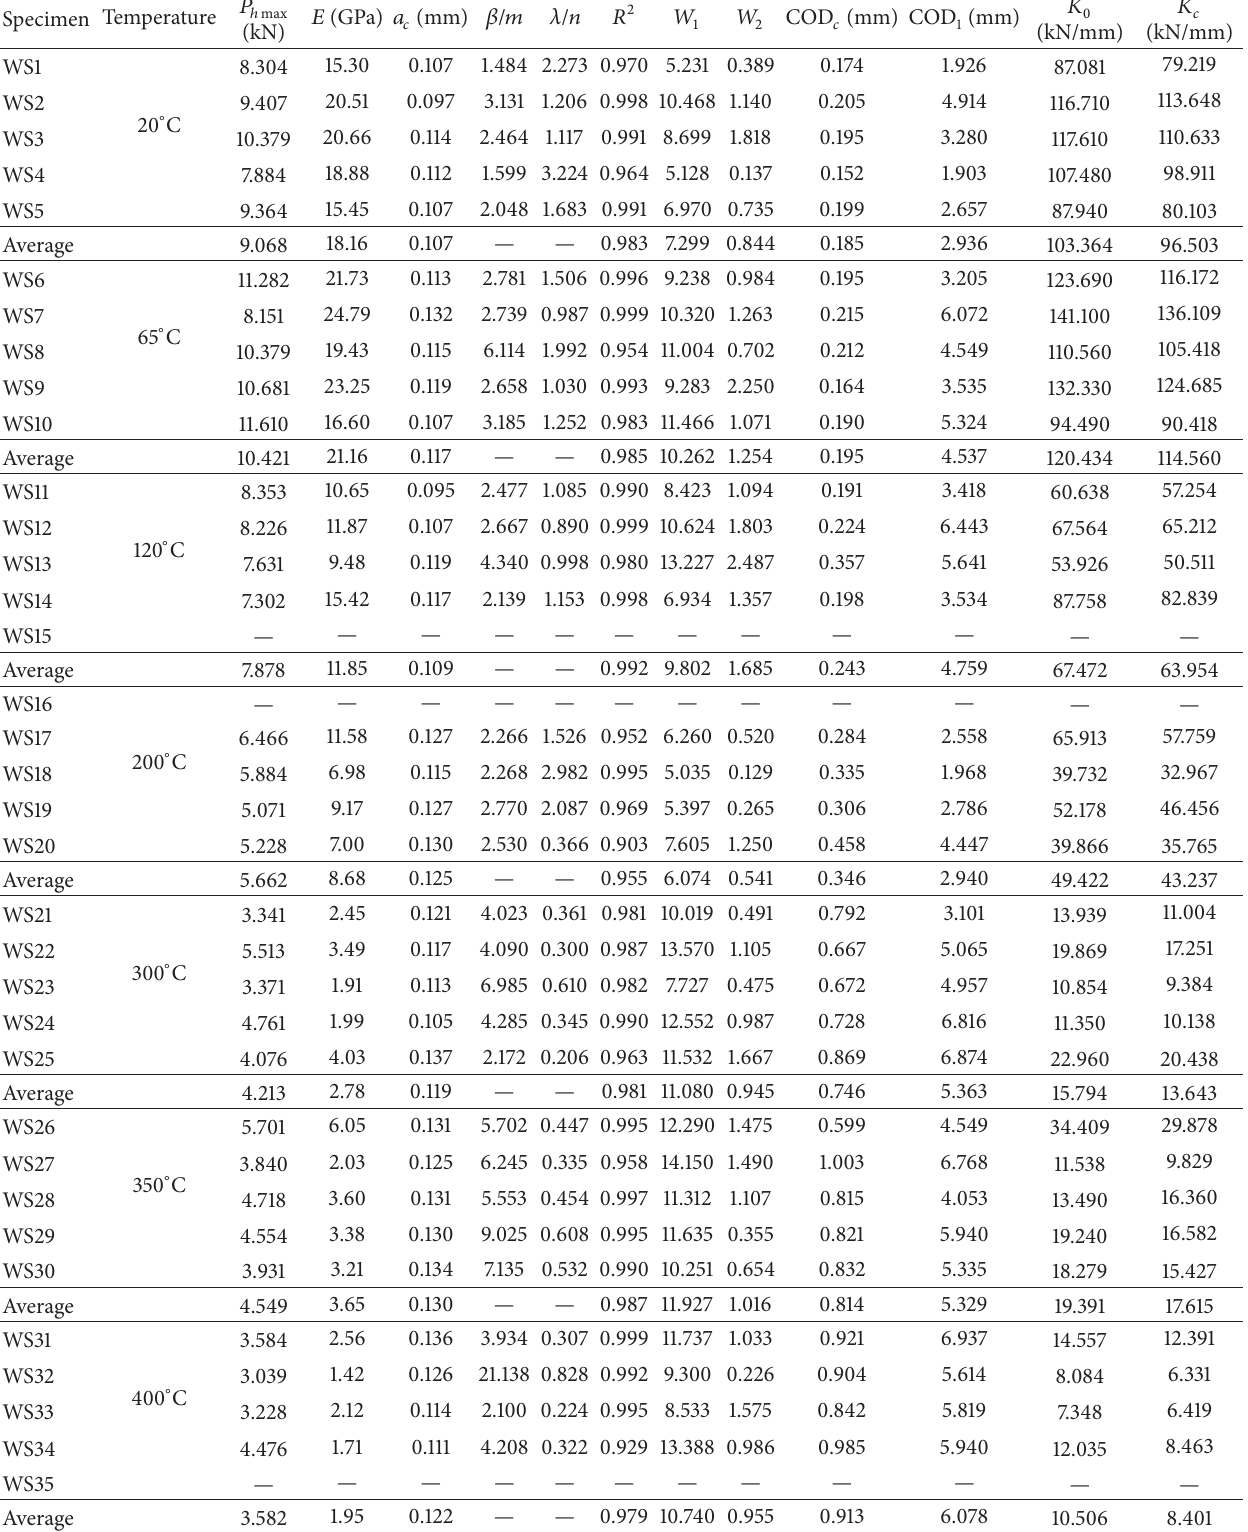
Table 1: Parameters calculated from wedge-splitting